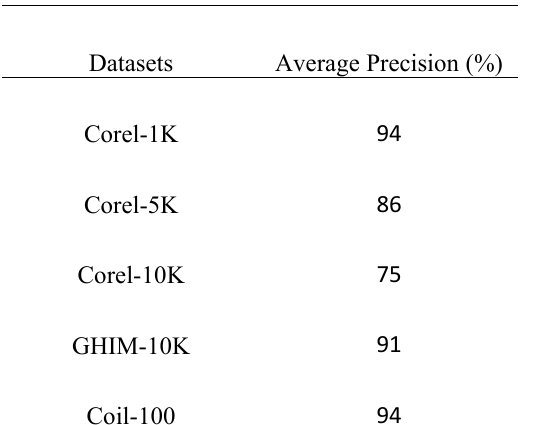
Table 2. Average precision of hybrid system